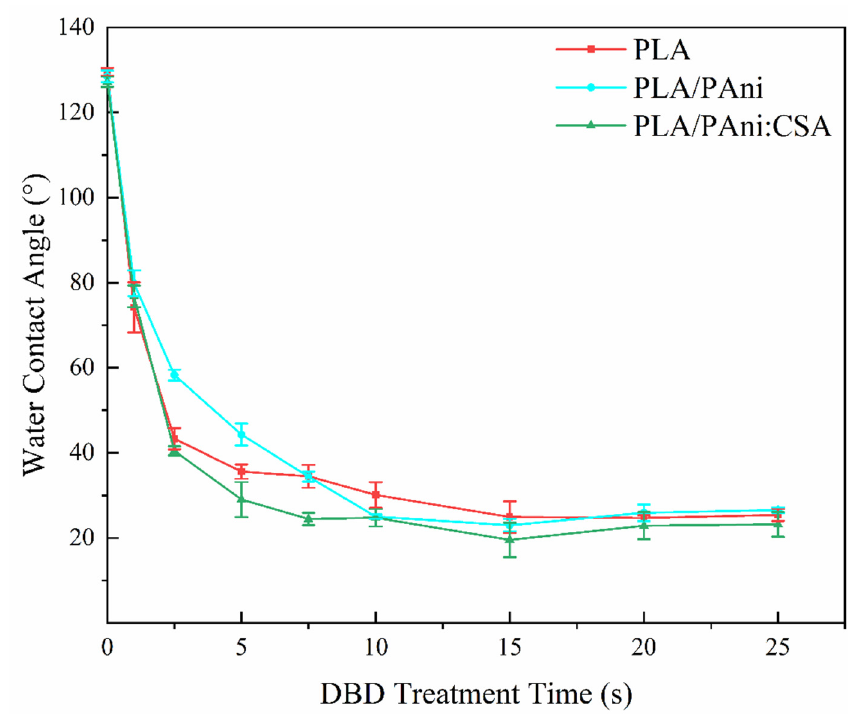
Figure 6. Evolution of the WCA values as a function of nitrogen DBD treatment time.